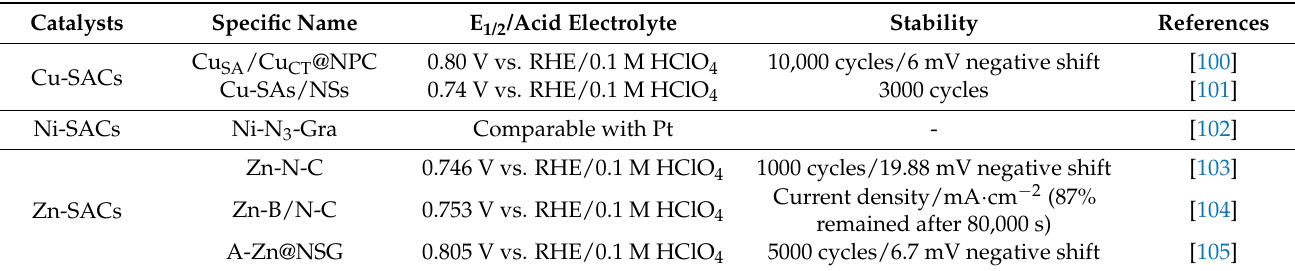
Table 1. Summary of the ORR performance for other metal